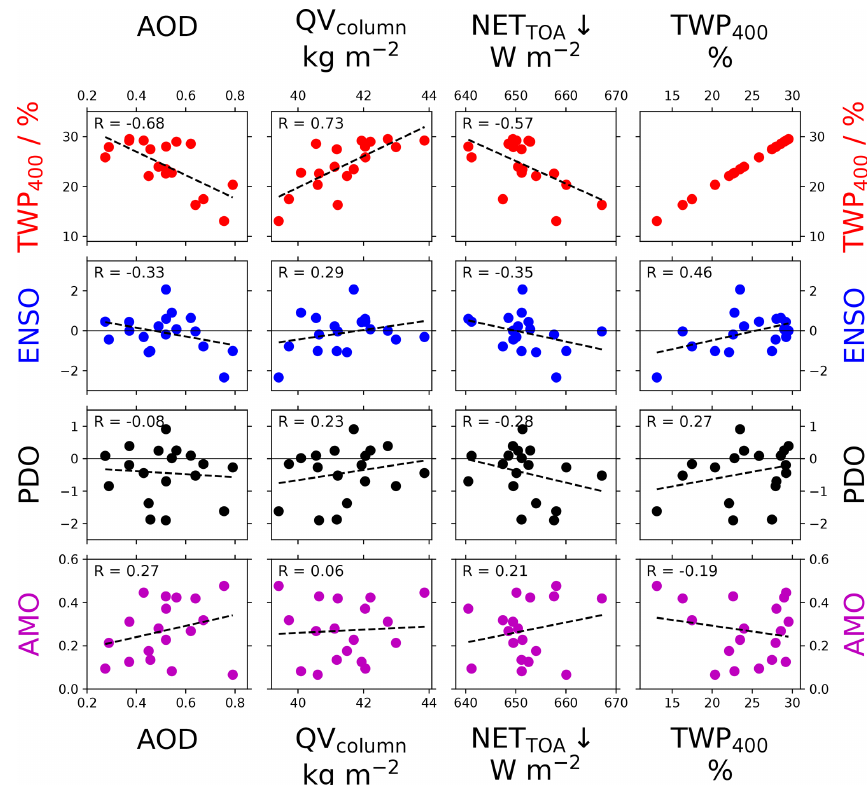
Figure 14. September mean AOD (first column), QV column (second column), NET TOA (third column), and TWP 400 (fourth column) from the domain for each year as a function of the corresponding (from the top row downwards) TWP 400 , August–September mean ENSO index, PDO index, and AMO index. TWP 400 is the percentage of the domain where TWP > 400gm − 2 and is used as a metric to describe the convective nature of the domain. The dotted line in each plot shows the linear regression between the two datasets, with the corresponding R value shown at the top of each